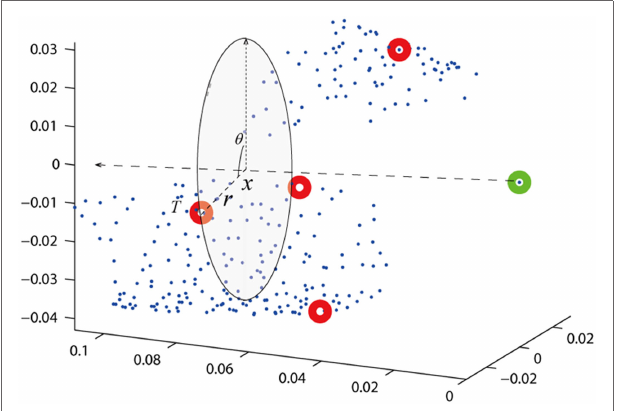
FIGURE 4 | The simplified model of generic robotic skin . The shape of the skin is arbitrarily approximated as a truncated